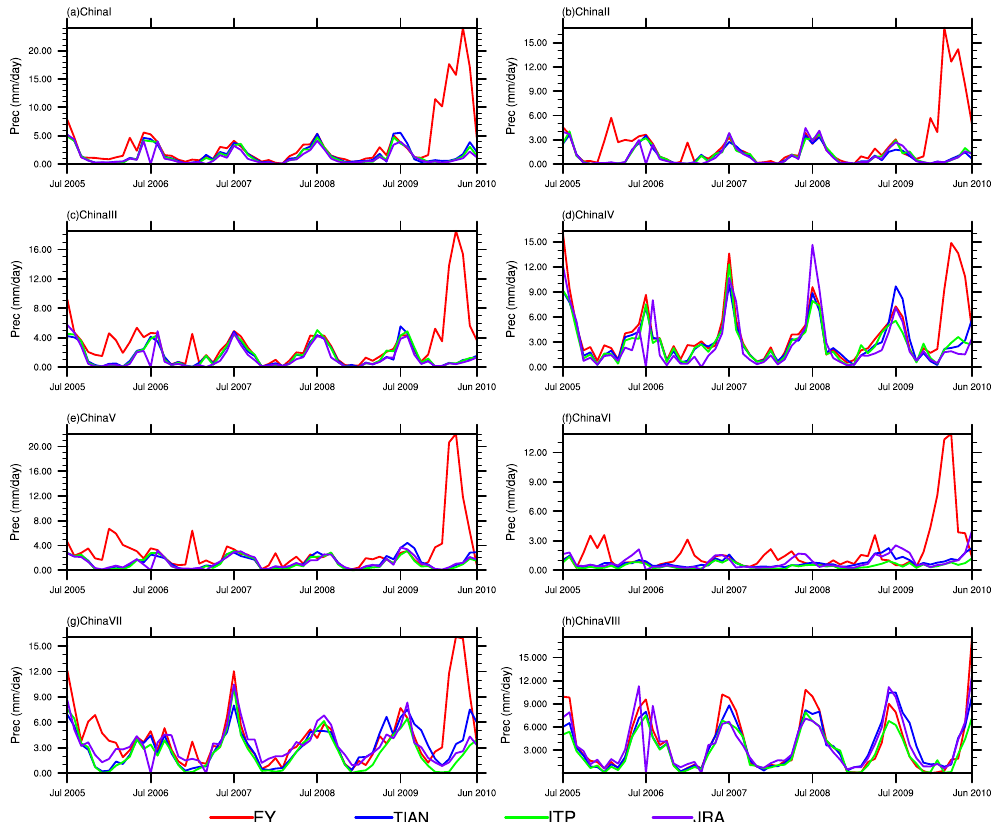
Fig. 4. Time series of precipitation (prec, mmday − 1 ) for July 2005–June 2010 from FY, TIAN, ITP and JRA in the eight subregions of China defined in Table